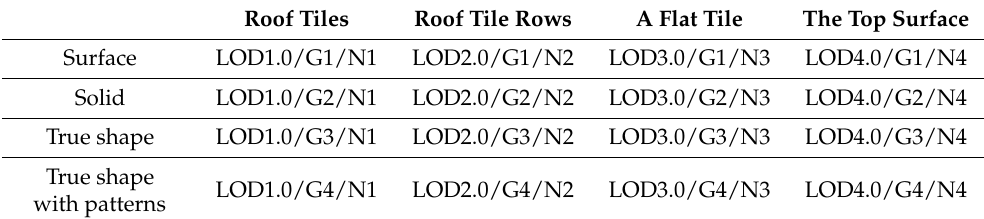
Figure 10. Using Web Station to launch a website. Table 1. Examples of